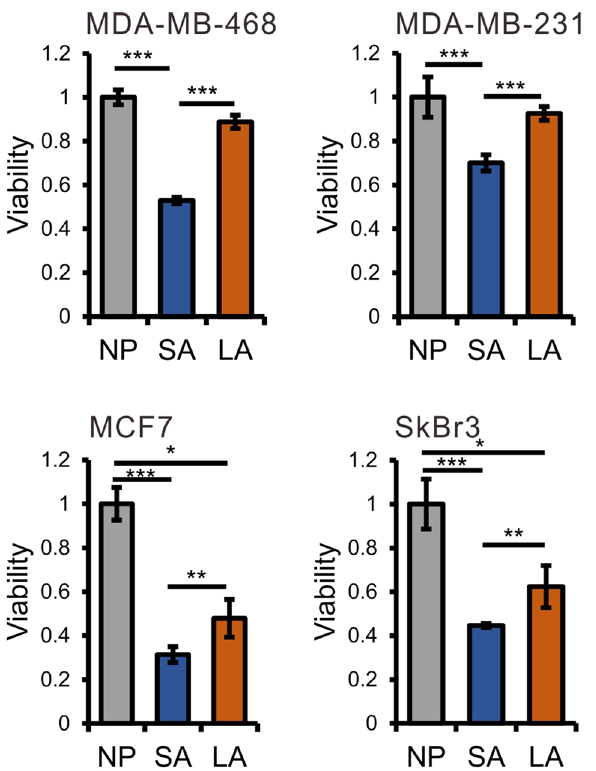
Figure 1. Lactate acidosis can reverse the decrease in viability of breast cancer cells induced by acidosis ( NP normal pH groups, SA acidosis groups, LA lactic acidosis groups). Values are expressed as mean ± SD. * P < 0.05, ** P < 0.01, *** P < 0.001 by unpaired Student’s test, n =